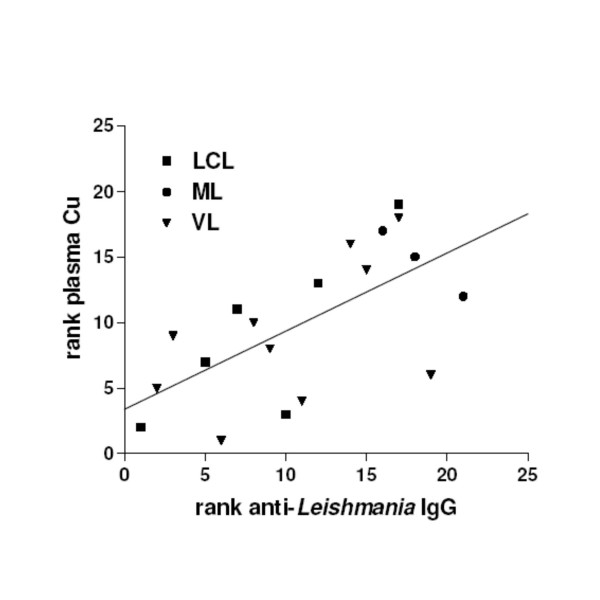
Correlation between plasma Cu and anti-Leishmania IgG. Plasma levels of Cu and anti-Leishmania IgG were positively correlated in patients with localized cutaneous leishmaniasis before treatment (LCL), mucosal leishmaniasis (ML) and visceral leishmaniasis (VL) (Spearman r = 0.65, p = 0.0028).